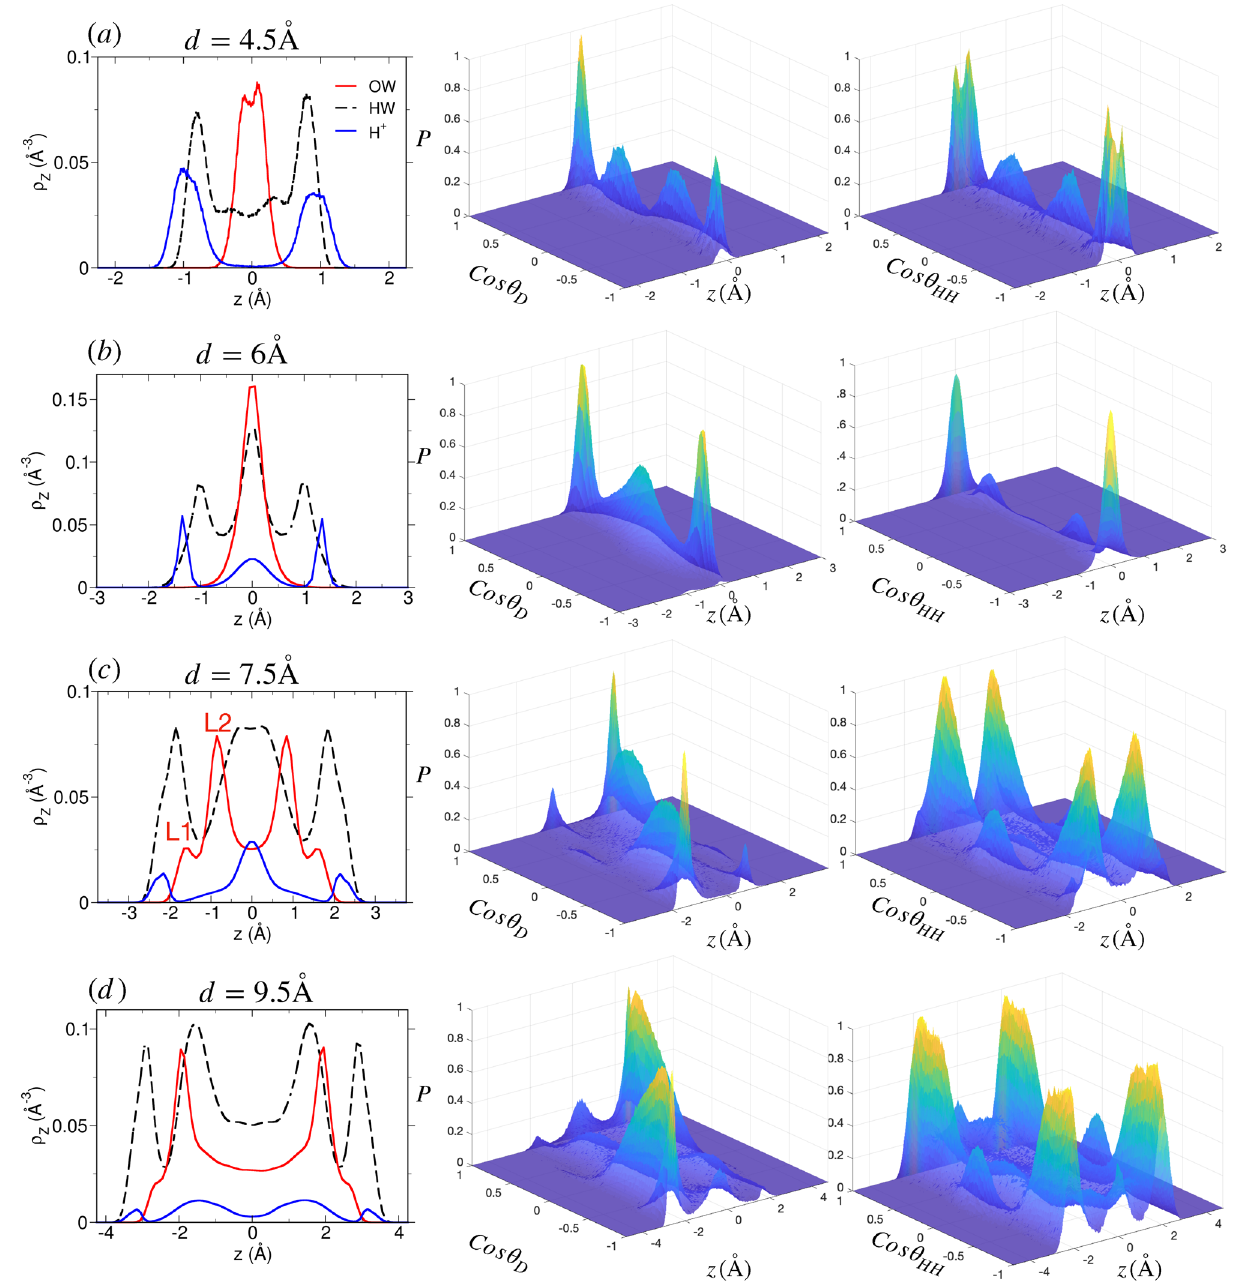
Figure 7. Structure of confined water and H + ion at various d in H-mica system. Legends are same as explained in Fig. 5. Note the difference in density of H + ions and water compared to Na- and Li-mica system shown in Figs. 5 and